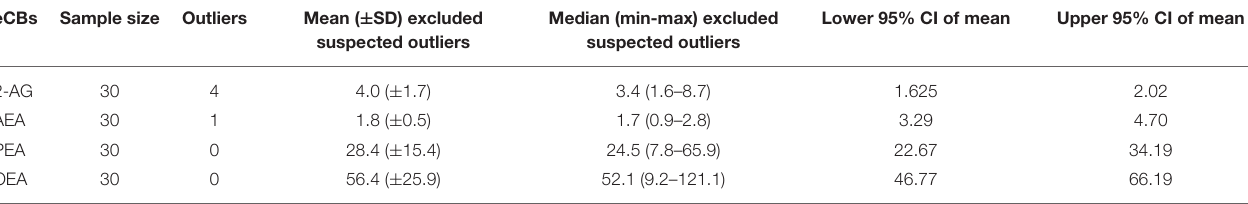
TABLE 4 | Median values, with minimum and maximum in brackets, of plasma endocannabinoids (eCBs) in dogs with chronic enteropathy (CE, n = 33) and control group ( n = 30).